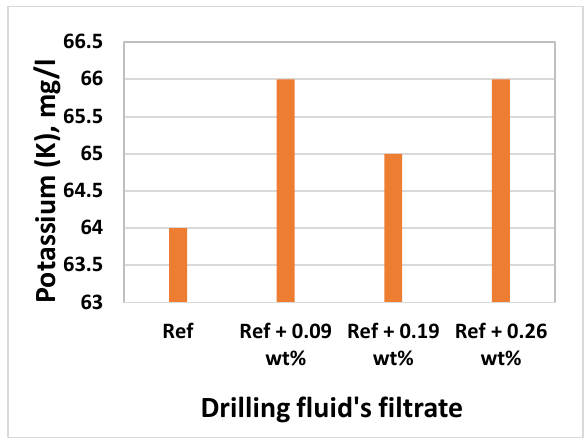
Figure 18. K in the filtrates of drilling fluids.